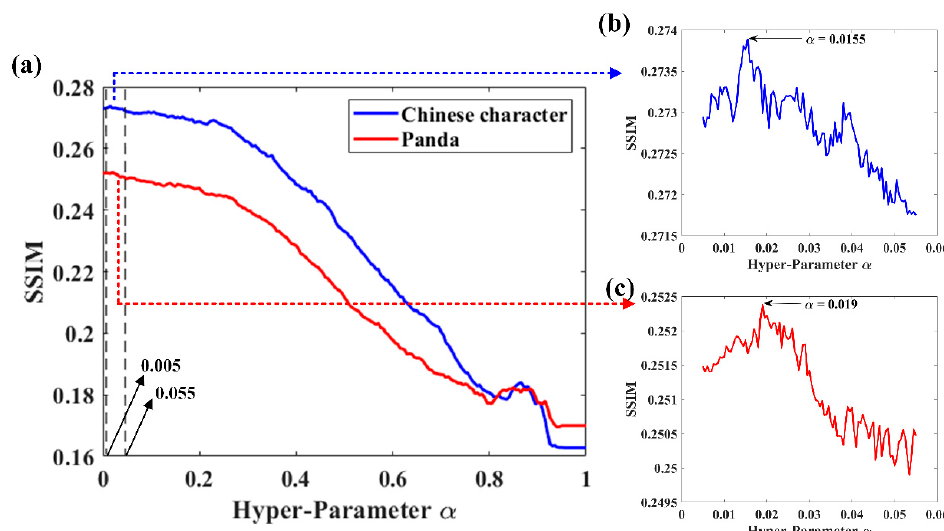
Figure 8. The curves of SSIM changing with the hyper-parameter α . ( a ) The SSIMs of image Chinese character and panda with the proposed method changing with the hyper-parameter α . ( b ) The SSIM curve of Chinese character with the proposed method when α changing from 0.005 to 0.055. ( c ) The SSIM curve of image panda with the proposed method when α changing from 0.005 to 0.055.